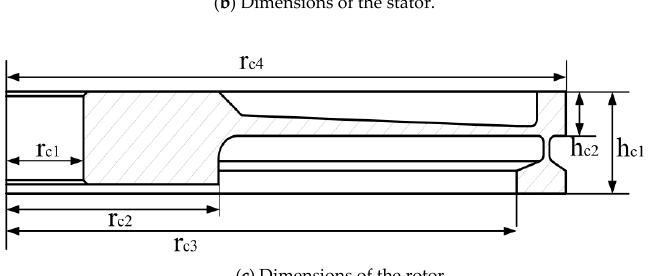
Figure 1. Typical structure of a travelling wave rotary ultrasonic motor.